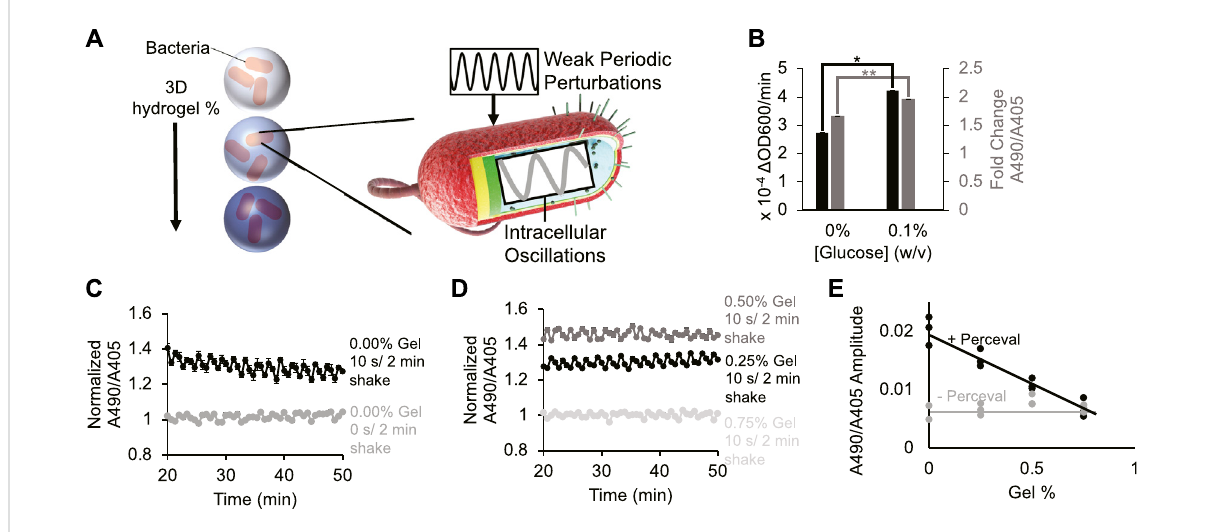
FIGURE 1 Periodic environment perturbations can propagate to intrabacterial metabolite oscillations despite hydrogel encapsulation. (A) Cartoon depictingbacteriaencapsulatedinvaryingdensitiesofhydrogelbeingsubjectedtoexternalkineticperturbation.Experimentassayswhetherexternal perturbationspropagatetointernal fl uctuationsincellularmetabolites. (B) Bacterialgrowthrate(blackbar)andtheirPercevalexpression(greybar)in M9 minimal medium (0% and 0.1% glucose, respectively). Difference between bacterial growth rates is signi fi cant ( p -value < 0.05, indicated by asterisk). DifferencebetweenPercevalvaluesissigni fi cant( p -value < 0.005,indicatedbytwoasterisks).Barheightrepresentsmeanvalues,anderror bars represent standard error of the mean. Mean and SEM are calculated using four biological replicates. (C) Intrabacterial ATP/ADP ratio over time with 0 or 10 s/2 min shaking. Absorbance at 490 nm to absorbance at 405 nm ratio represents ATP/ADP ratio. Basal fl uctuation in A490/ A405 without shaking is likely caused by the mechanical movement of the platereader to read the samples. Points represent mean values, and error bars represent standard error of the mean. Mean and SEM are calculated using four biological replicates. (D) Intrabacterial ATP/ADP ratio at different hydrogel densities (0.25% – 0.75% gel). Absorbance at 490 nm to absorbance at 405 nm ratio suggests that periodic perturbation of hydrogel encapsulated cells can propagate to changes in intracellular metabolites. Points represent mean values, and error bars represent standard error of the mean. Mean and SEM are calculated using four biological replicates. (E) Amplitude of ATP/ADP fl uctuations at 0.5 cycles/min in Escherichia coli DH5 α cells(greyline)andPercevalcells(blackline)shakenfor10 s/2 minatdifferentgeldensities(0% –